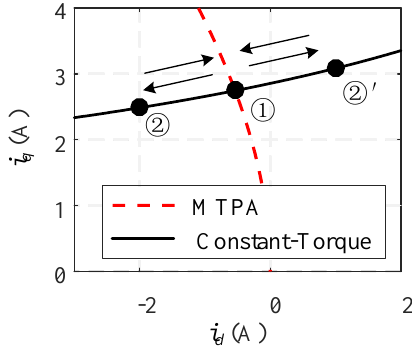
Figure 2. Two steady states of a salient-pole permanent magnet synchronous motor (PMSM).